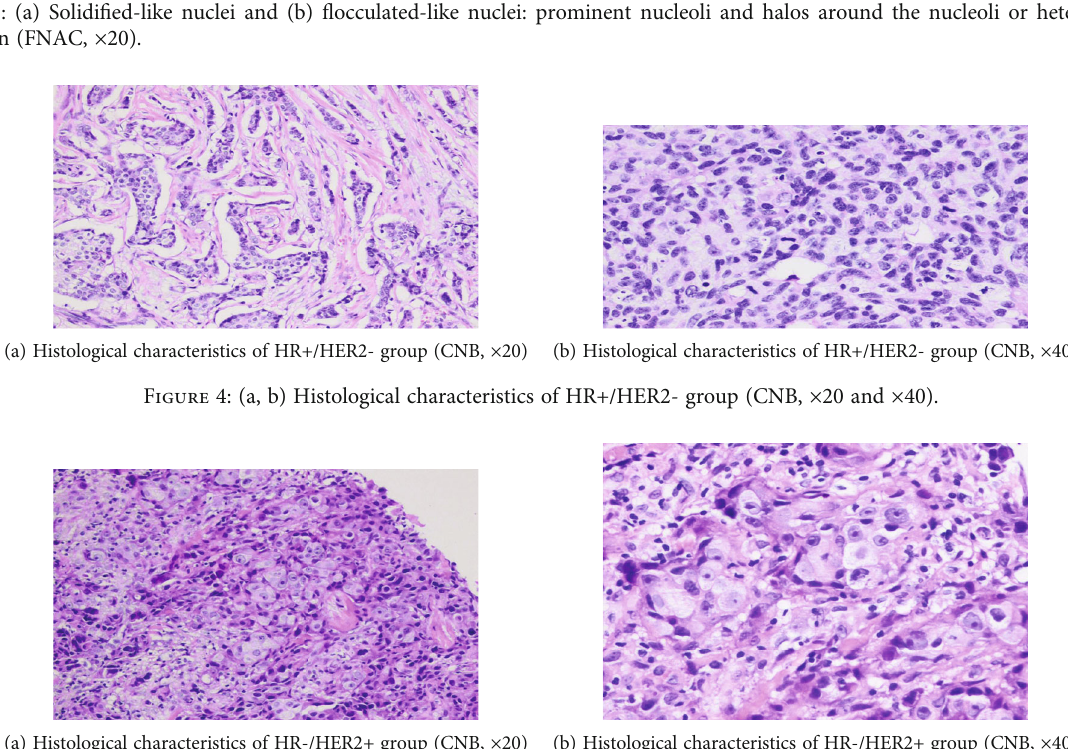
Figure 5: (a, b) Histological characteristics of HR-/HER2+ group (CNB, × 20 and ×